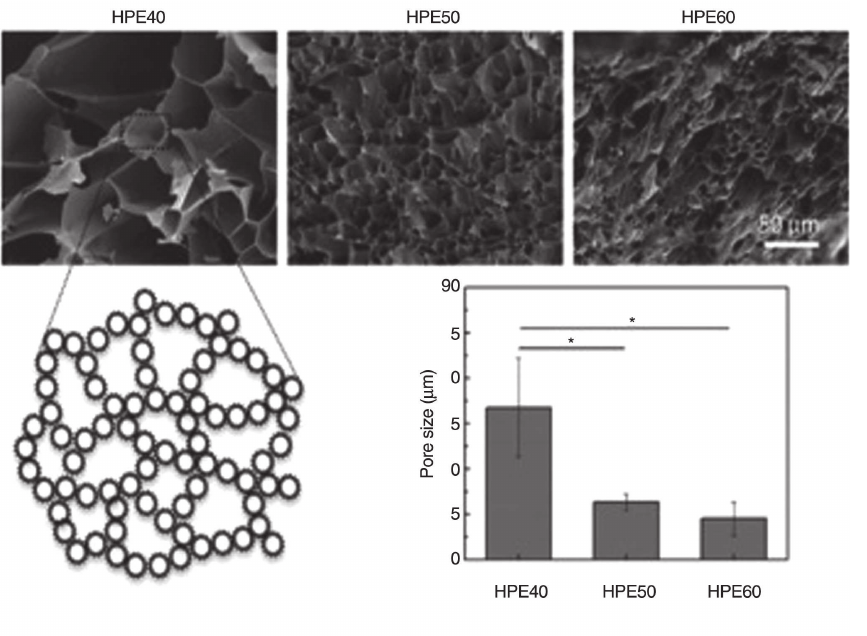
Figure 7: The effect of HPE macromolecule concentration on the microstructure of freeze-dried hydrogel network evaluated using SEM. Adapted with permission from Ref. [20], Copyright (2013) American Chemical Society.